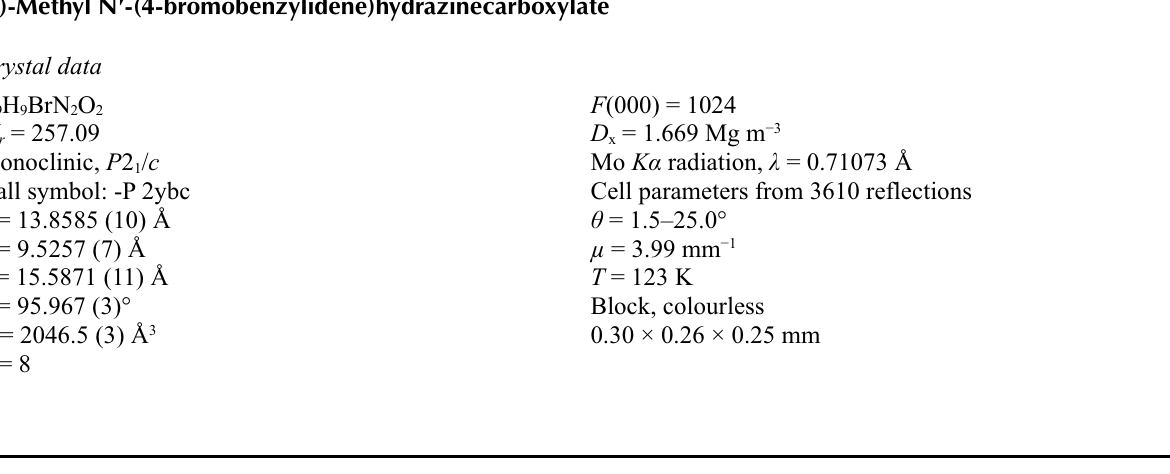
The crystal packing of the title compound. Hydrogen bonds are shown as dashed